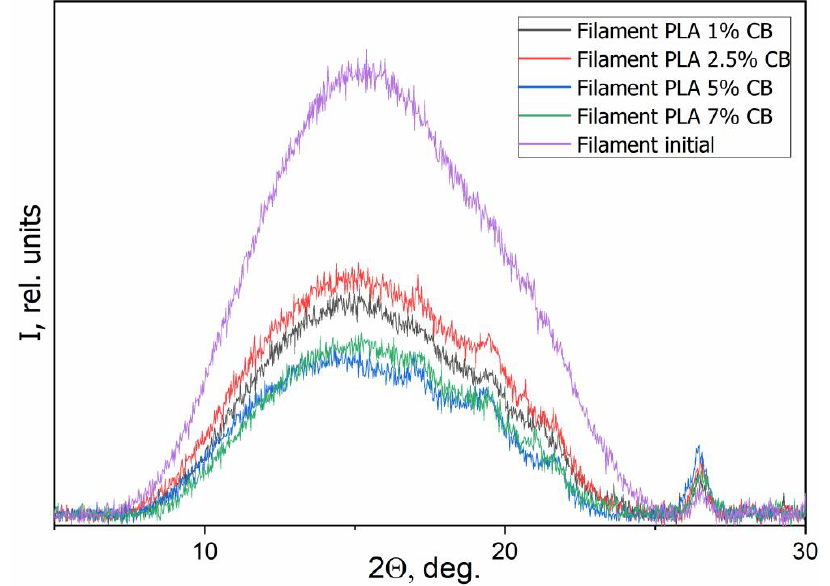
Figure 12. WAXS patterns of the composite filaments with various CB content φ .